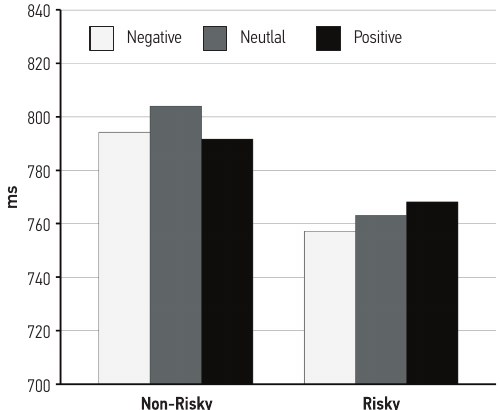
Fig. 2. Response latency (Experiment 1). Average reaction times according to risky situation and emotional warning